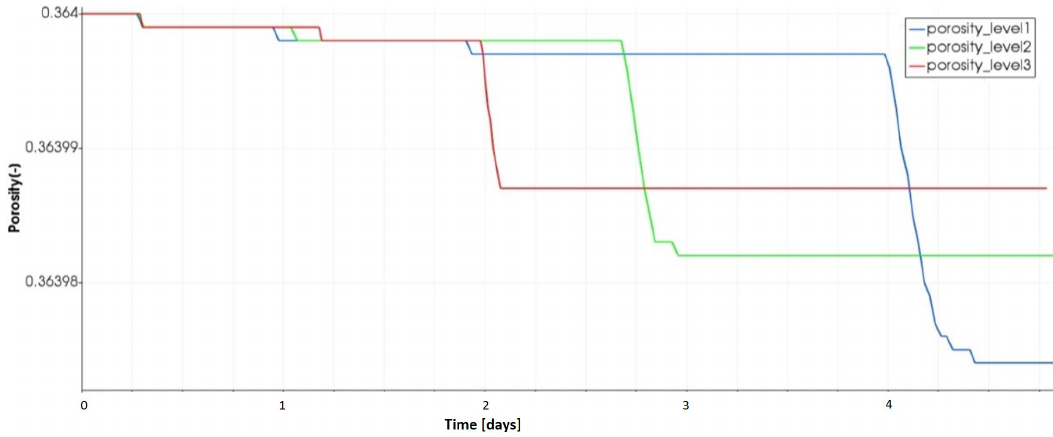
Figure 19. Evolution of the initial porosity for different water table